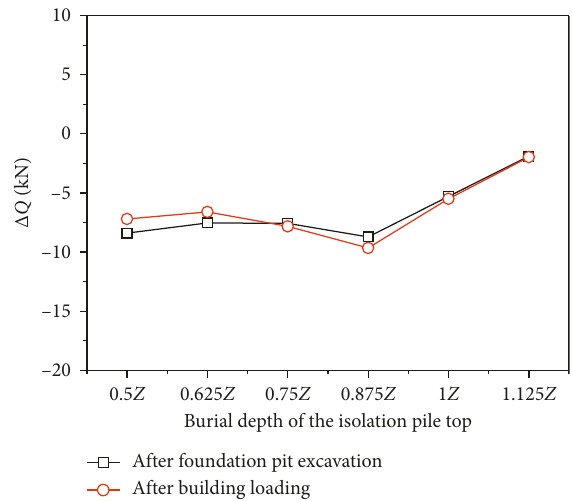
Figure 27: Difference between the additional normal forces.